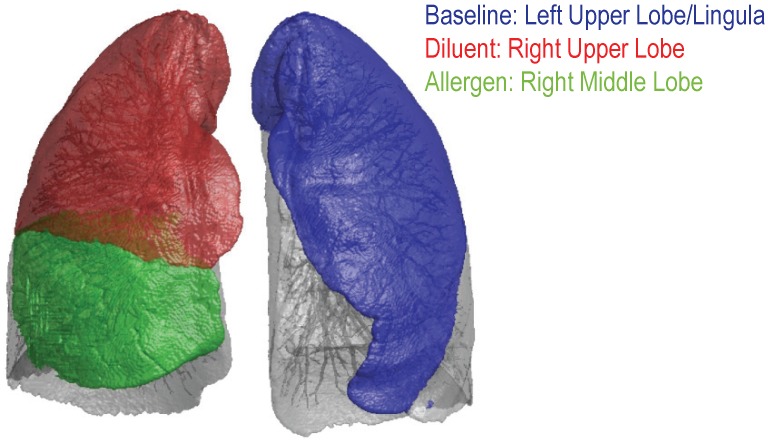
Lung image demonstrating the location of the different lung lobes.The left upper lobe (LUL) was used as the baseline (blue), the right upper lobe (RUL) was used as the diluent lobe (red) and the right middle lobe (RML) was the allergen exposed lobe (green).